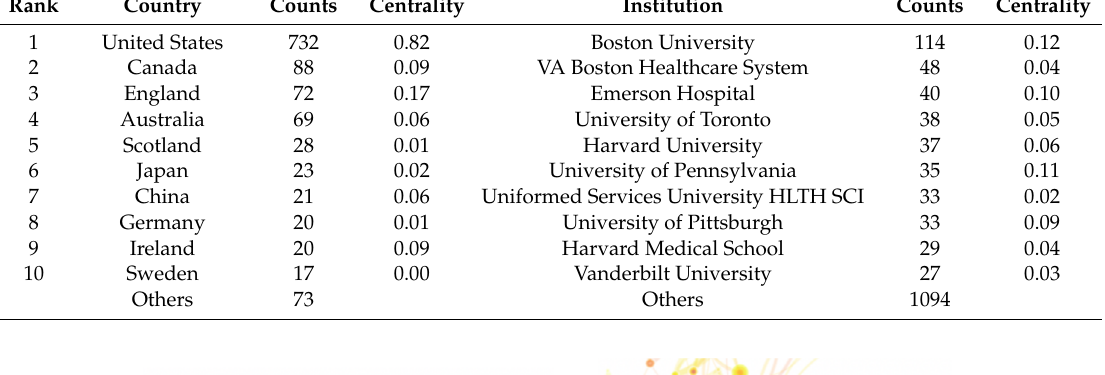
Table 1. Ranking of top 10 active countries and institutions in the field of CTE research from 1999 to 2019.